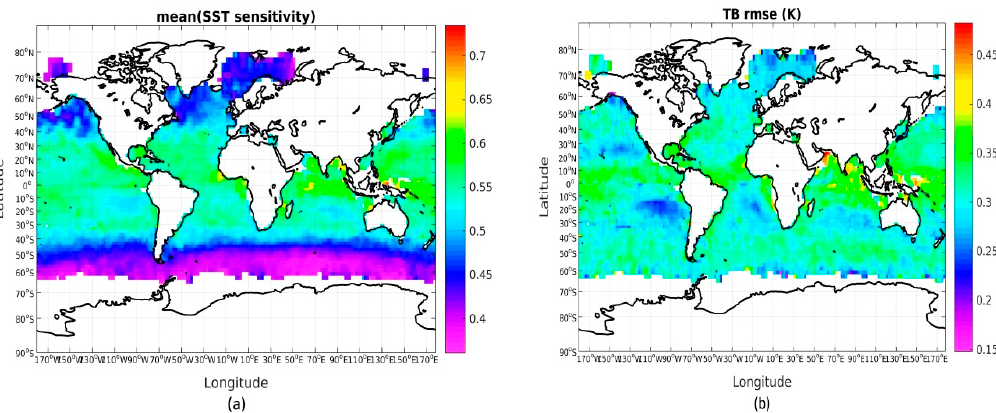
Figure 10. Gridded statistics of ( a ) mean sensitivity and ( b ) mean RMSE TB . Only retrievals with a corresponding RMSE TB < 0.5 K are plotted.